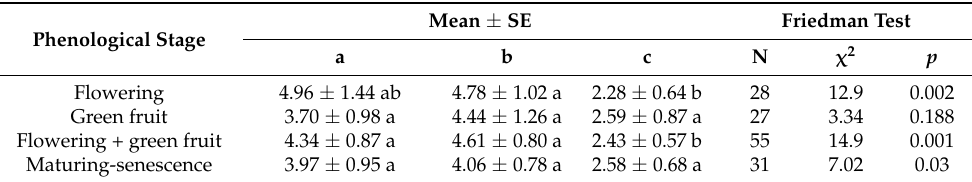
Table 3. Location of Helicoverpa armigera eggs within the plant in processing tomato crops in the Ribatejo region—comparison of the number of eggs in each location per phenological stage—results from Friedman nonparametric tests and multiple comparison of the medians 1 (SE—Standard error of the